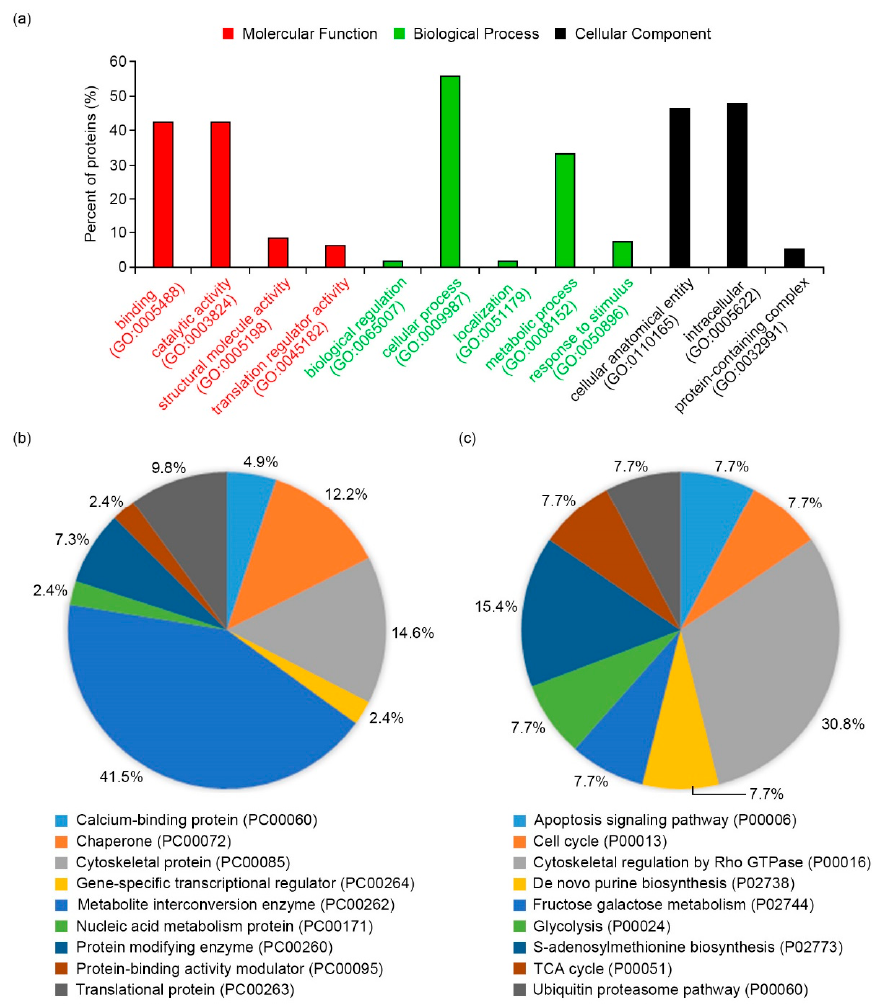
Figure 3. Functional classification of DEPs using the PANTHER database. ( a ) The bar chart of molecular function (red), biological process (green), and cellular components (black) represented is based on the PANTHER GO analysis. ( b ) Bar chart of the PANTHER protein classes in DEPs. ( c ) Bar chart of the PANTHER pathway classes in DEPs. The input percentage was calculated on the basis of the number of proteins mapped to the GO term divided by all protein numbers in the lists of DEPs ( Arabidopsis thaliana IDs from the NCBI database). Table 1. Identification of DEPs between control A0 and salt-adapted A120 Arabidopsis callus suspension-cultured cells. Spot Locus No. No. a